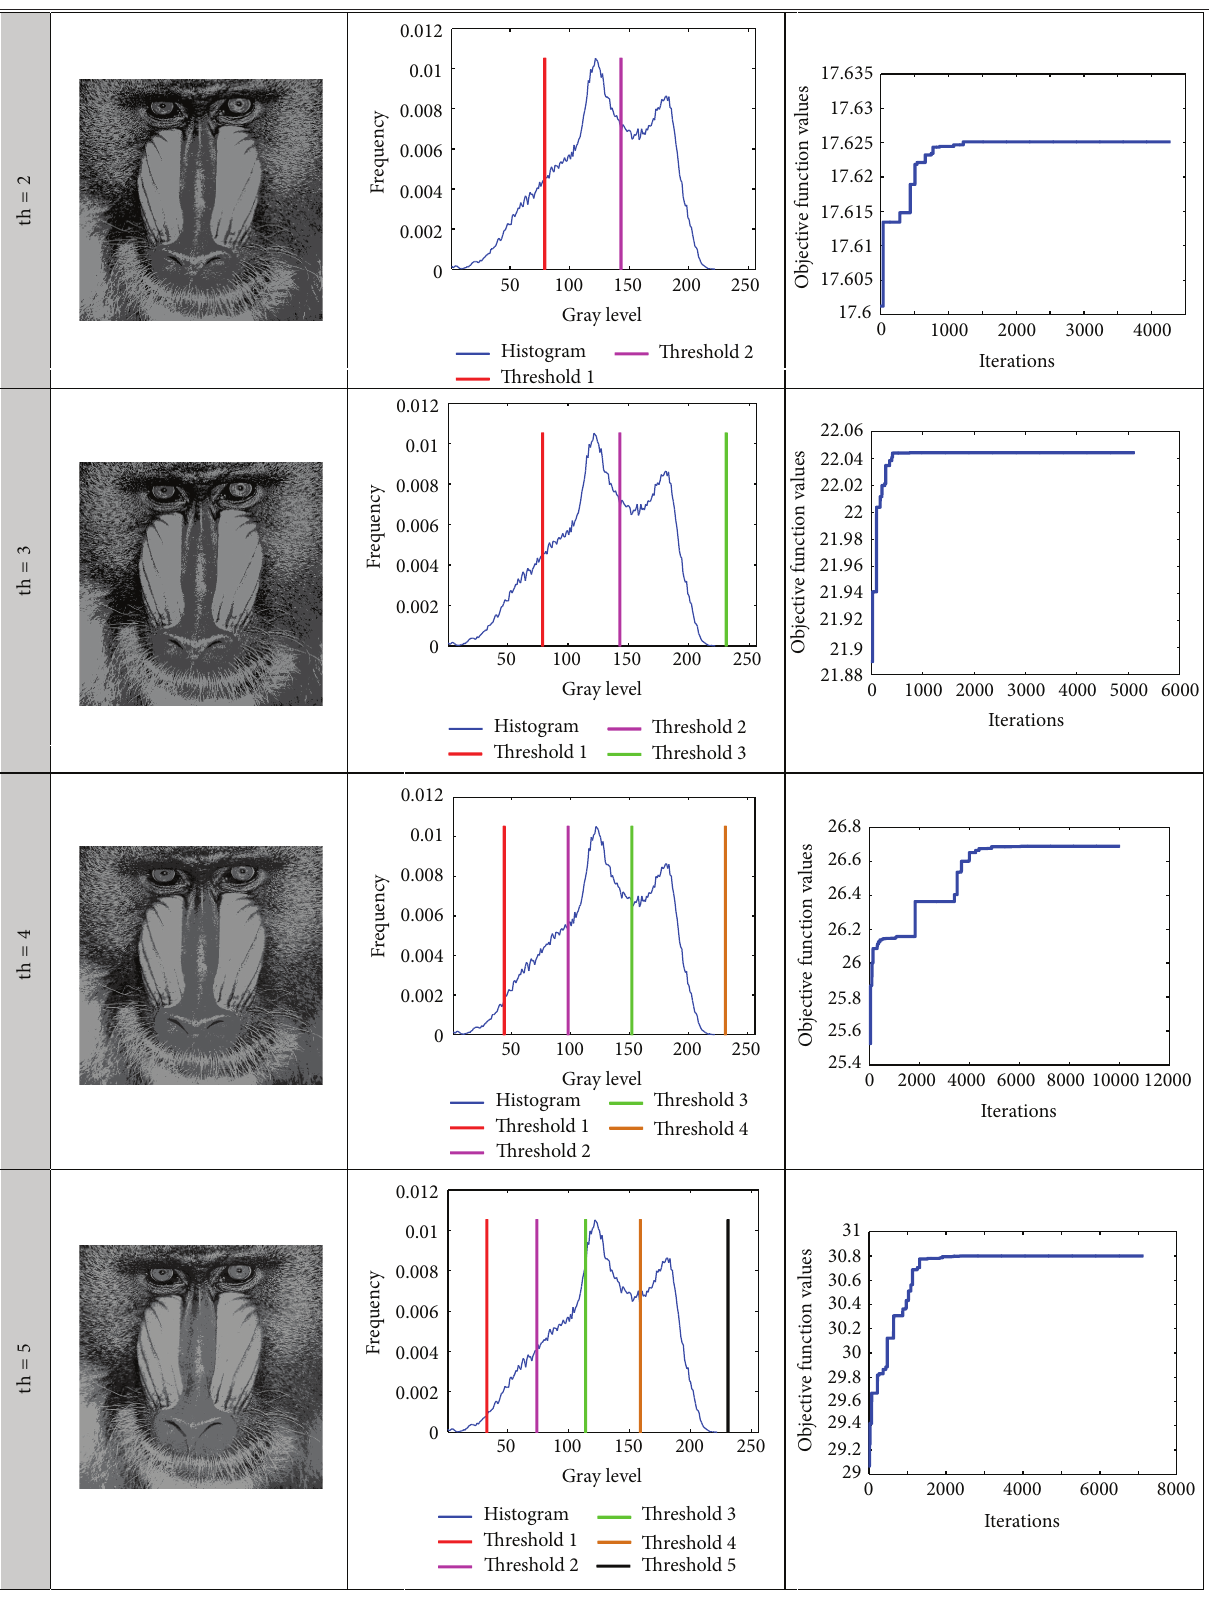
Table 12: Results after appling the HSMA using Kapur’s over the Baboon